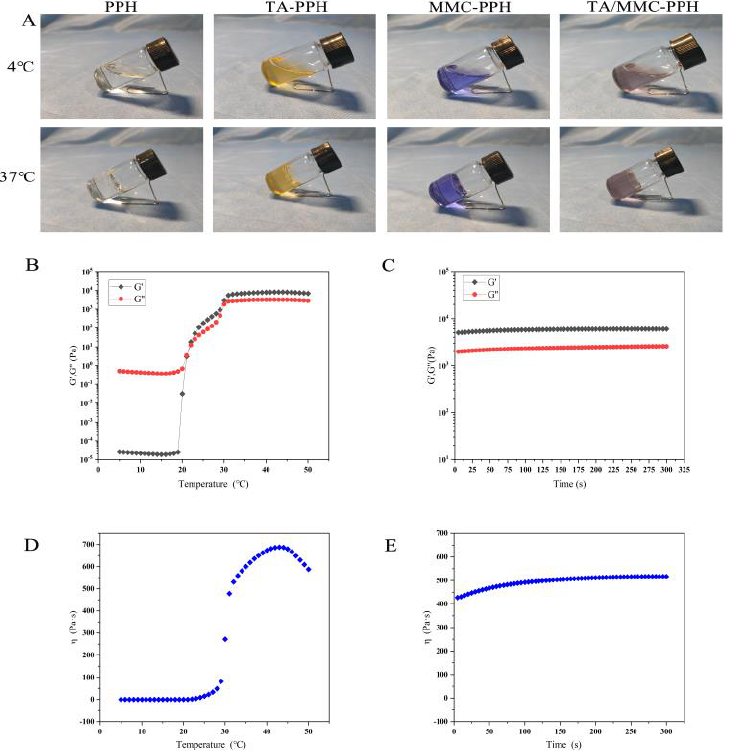
Figure 1. State of each group of hydrogels at 4 °C and 37 °C ( A ) and rheological analysis of the PPH hydrogel. ( B ) Storage modulus (G ′ ) and loss modulus (G ″ ), and ( C ) complex viscosity of the PPH hydrogel as a function of temperature; ( D ) storage modulus (G ′ ) and loss modulus (G ″ ), and ( E ) complex viscosity of the PPH hydrogel as a function of time at 37 °C.